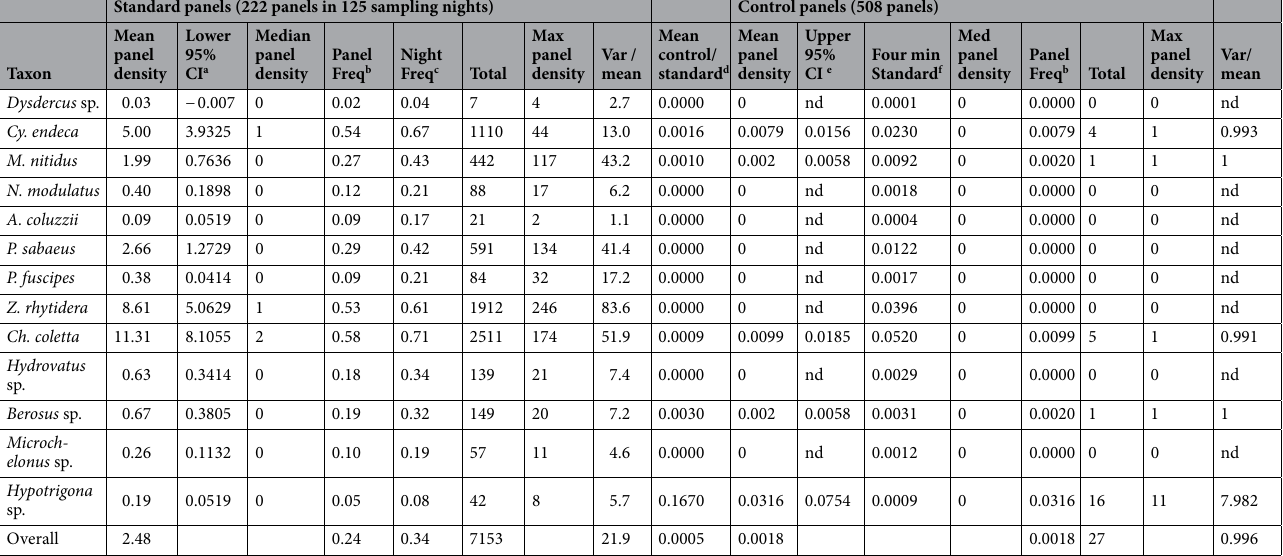
Table 2. Overall abundance and occurrence of selected taxa in aerial samples collected on standard panels (220 panels between 40 and 290 m agl, in 125 sampling nights) and control panels (508 nets between 40 and 120 m agl). a The lower 95% confidence interval (CI) of the mean panel density of standard panel used to compare with the upper 95% CI of the control panel for each taxon (see text). b Panel Frequency – Frequency of panels with at least one specimen per taxon. c Night Frequency – Frequency of nights with at least one specimen per taxon per night regardless of village (ie., includes nights when launches occurred in more than one village, n = 96). d Overall mean ratio of control/standard panel and mean control panel density were computed excluding Hypotrigona sp. (see text). e Expected density assuming insects were intercepted while the control panels reached over 20 m and remain there for ~ four minutes (see